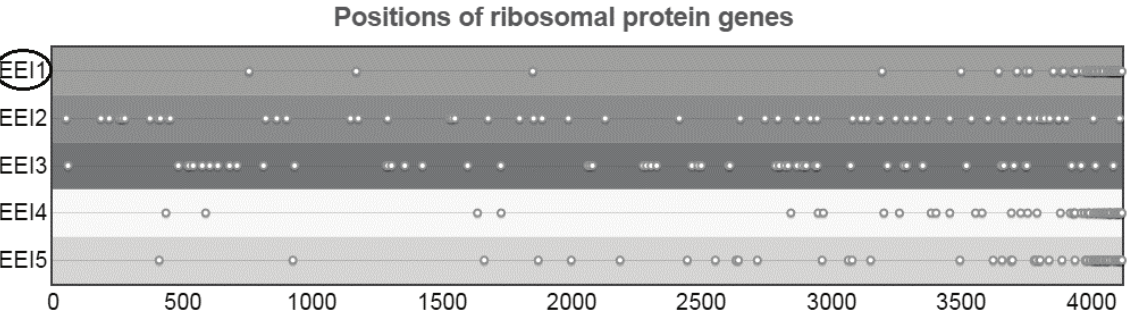
Figure 3: Distribution of ribosomal protein genes (dots) in the list of E. coli K-12 MG1655 genes sorted in ascending order by EEI1-5. EEI1 is the best (marked by oval), ribosomal protein genes are placed more on the right side and denser to each